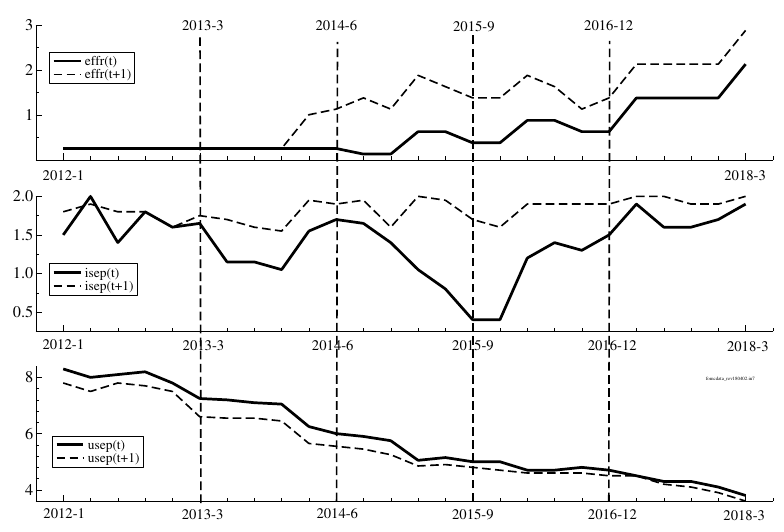
Figure 6. FOMC Forecasts—Current and One Year